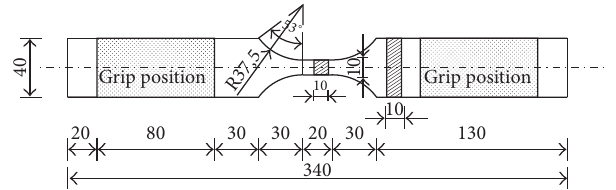
Figure 1: Shape and size of the specimen